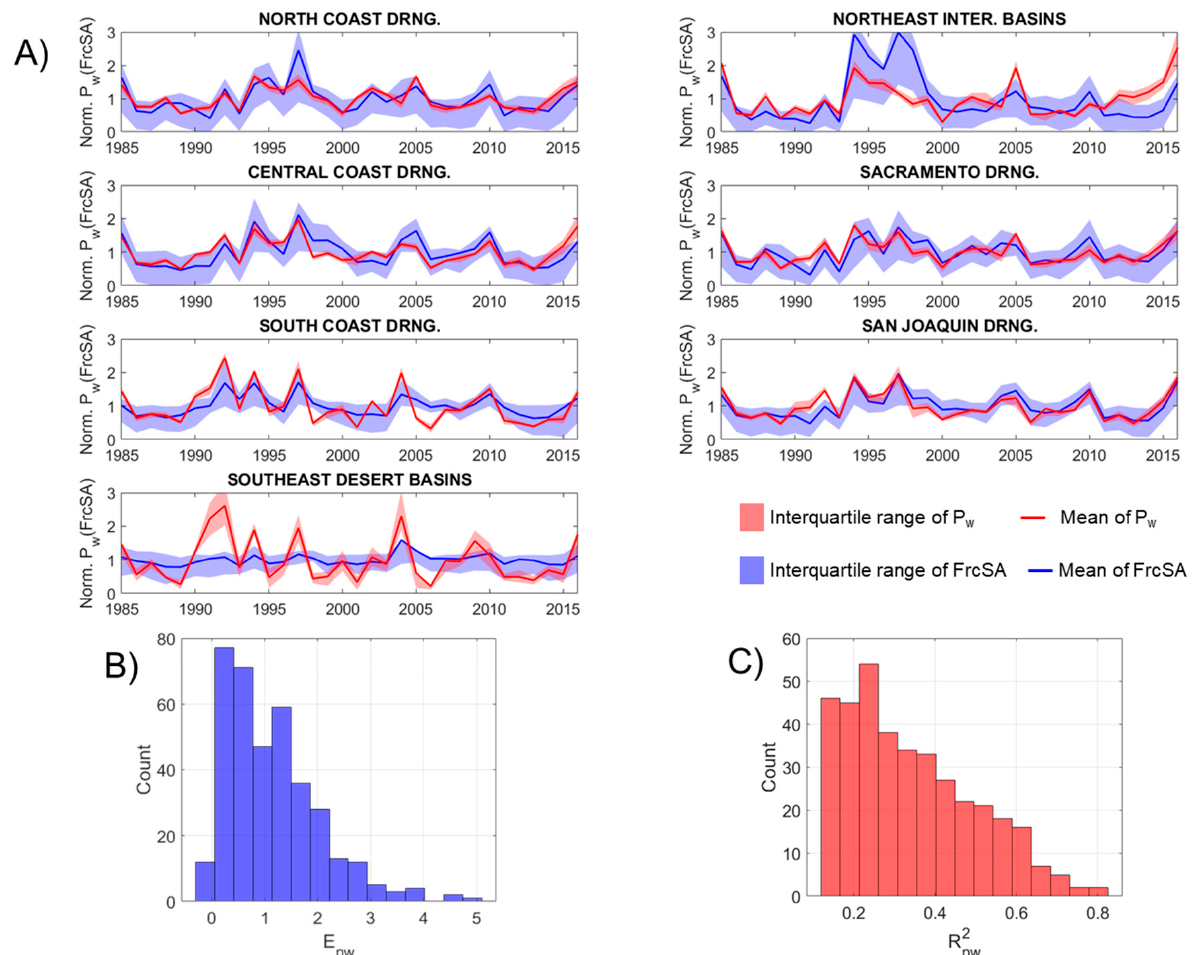
Figure 10. Mean and interquartile range of annual mean FrcSA and winter precipitation (Pw) for order-1/order-2 reaches in seven climate divisions ( A ), histograms for the elasticity of FrcSA to P w (E pw ) ( B ) for 332 reaches with p value below 0.05 ( B ) and corresponding coefficient of determination (R 2pw ) ( C ).